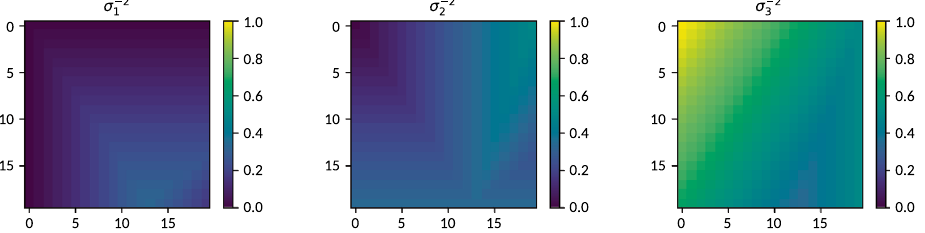
20 grid) of possible eigenvalue combinations in T × 2 1 / 3, 1 / 2 , σ − 2 arising from 3 ∈ [ 2 ]